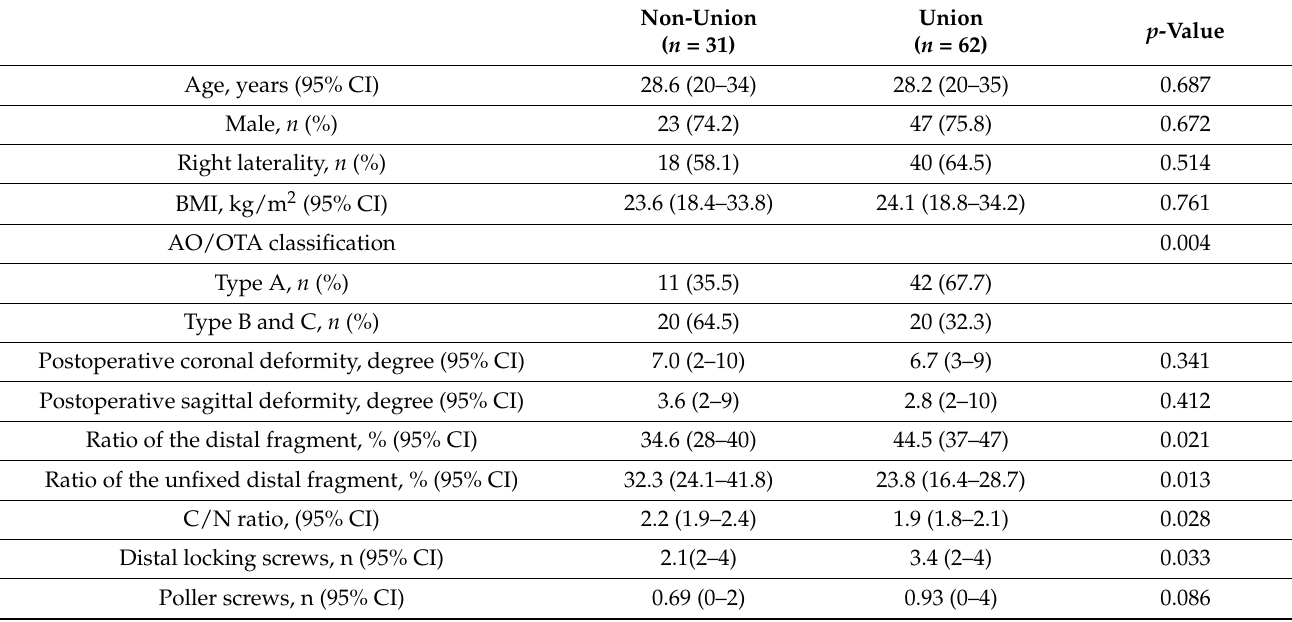
Table 1. Study variables and their association with non-union and union of fractures.